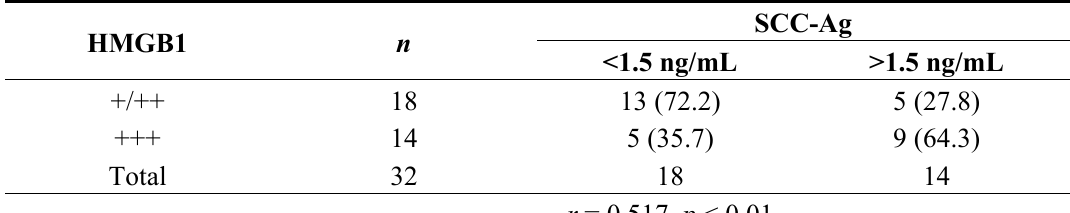
Table 4. Relationship between SCC-Ag and HMGB1